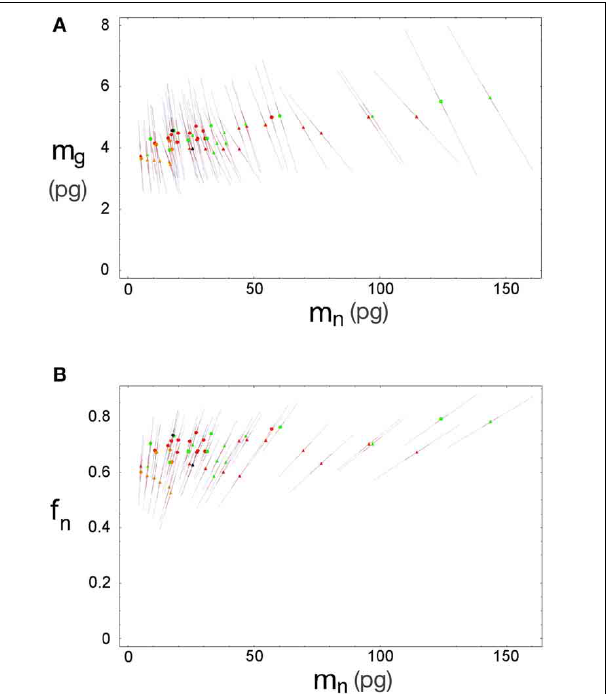
FIGURE 5 | Errors for estimated neuronal and glial cell masses and neuronal mass fraction. Each point indicates the estimated average neuronal cell mass, m n , and average glial cell mass, m g (A) or neuronal mass fraction, f n (B) for a given brain structure in a species: cerebral cortex (circles), cerebellum (squares) and rest of brain (triangles) in eulipotyphlans (orange), primates (red) and rodents (green). Errors are shown as bars ranging from each point. Figure 8A ), but not from measured glial cell density. Conversely, m g can be estimated reliably for the cerebral cortex and rest of the brain from the measured glial cell density in the tissue, accord- ing to the function m g = 1.648 ( d − 1 ) 0 . 370 ± 0 . 017 ( r 2 = 0 . 897, gmes p < 0 . 0001; Figure 8B ), but not from measured neuronal density.